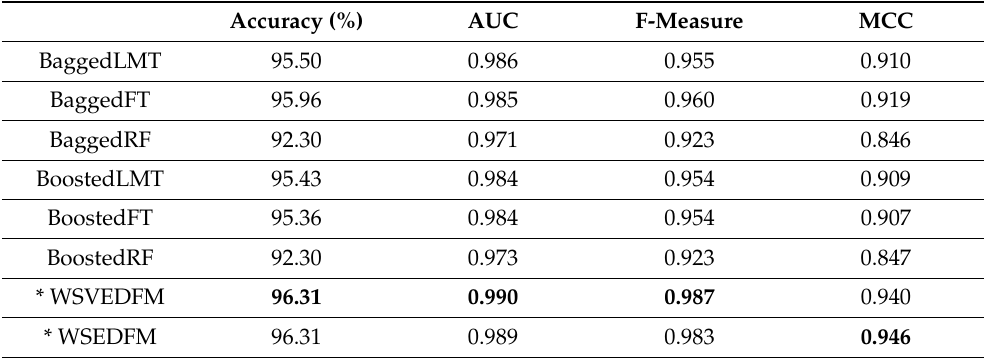
Table 13. The CCP performance of DF models and their Enhanced ensemble variants on balanced Dataset